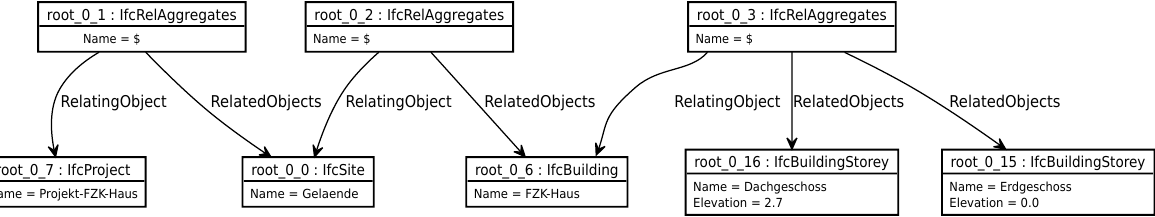
Figure 8. IFC instance of the spatial building structure